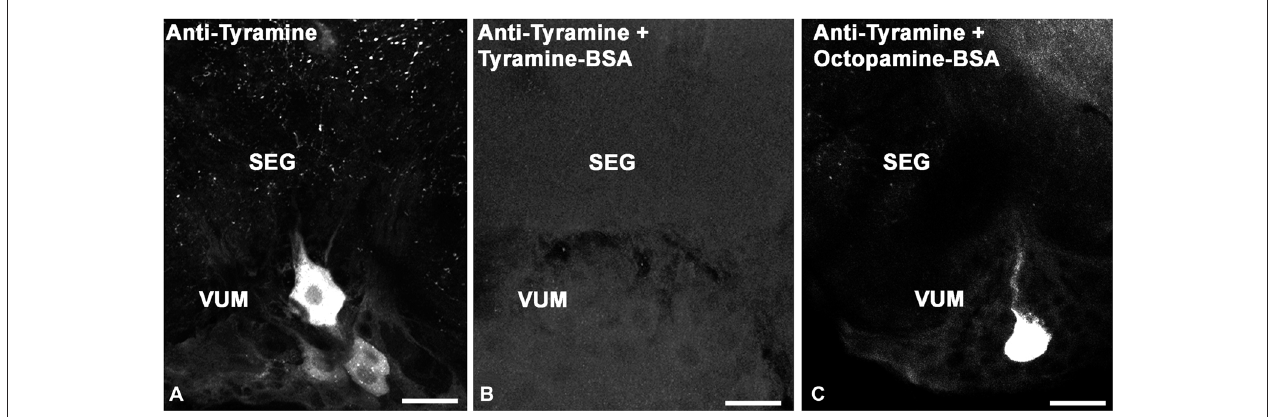
FIGURE 1 | Controls for immunolabeling with tyramine antiserum. We used three sections of the subesophageal ganglion (SEG) that contain ventral median group cells (VUM). The sections were labeled with one of the following: (A) tyramine antiserum; (B) tyramine antiserum pre-incubated with conjugated tyramine-bovine serum albumin (BSA); (C) tyramine antiserum pre-incubated with octopamine-BSA. Scale bar: 25 µ m.